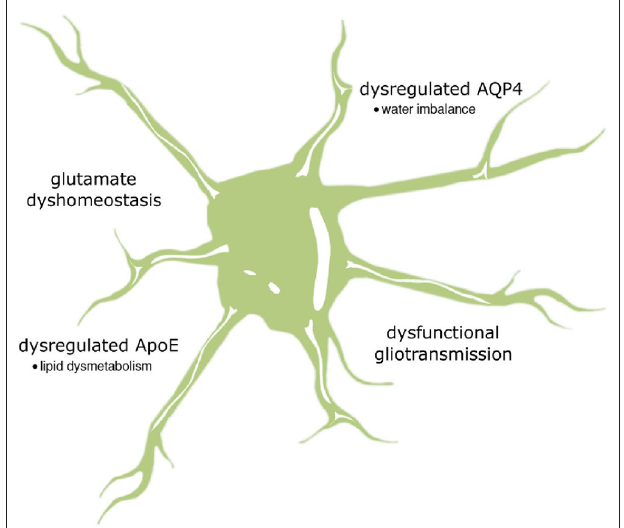
FIGURE 2 | The summary of possible impact of astrocytic cAMP and Ca 2 + signaling on neurodegenerative pathology. It is supposed that altered relationship between calcium and cAMP may be substantially relevant to the loss of gliotransmission and glutamate uptake as well as changes in the activity of two important proteins, AQP4 and ApoE, regulating water transport and lipid homeostasis,